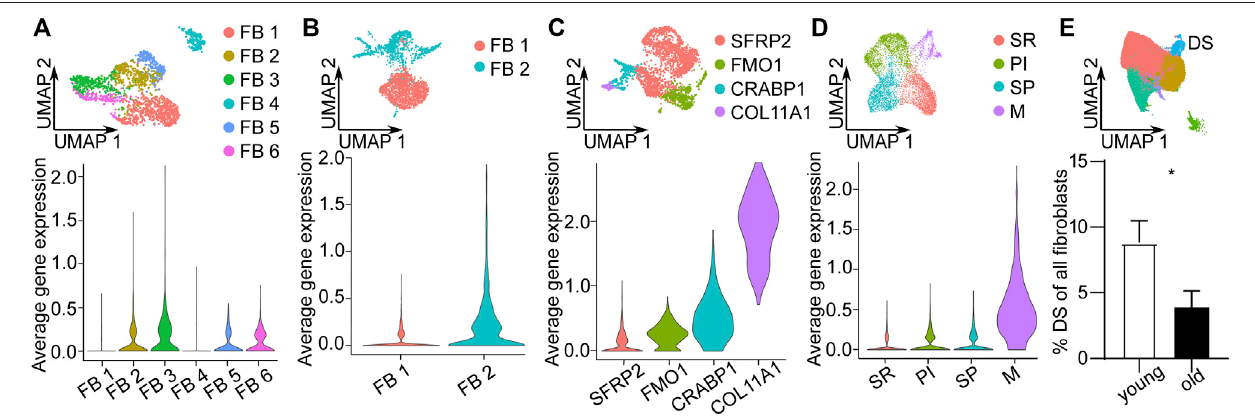
FIGURE 3 | Validation of Dermal sheath (DS) population and its loss upon aging in independent scRNA-seq datasets. Uniform Manifold Approximation and Projection (UMAP)plotsof fi broblastpopulationsfrom (A) Vorstandlechneretal.,2020, (B) Rojahnetal.,2020, (C) Tabibetal.,2020and (D) Solé-Boldoetal.,2020.Violinplotsoftheaverage expression of the ten most upregulated genes of DS population ( COL11A1 , DPEP1 , POSTN , TAGLN , MEF2C , MYL4 , TNMD , WFDC1 , GPC3 , PPP1R14A ) in these datasets. (E) UMAPplot of fi broblastsofotherdatasets integratedtogetherwithourdataset. PercentageofDSpopulation youngvs. old, n (cid:1) 8(young), n (cid:1) 9(old). * p < 0.05 (two-tailed unpaired t -test), mean +/- SEM. FB Fibroblasts, SR secretory-reticular, PI pro-in fl ammatory, SP secretory-papillary, M